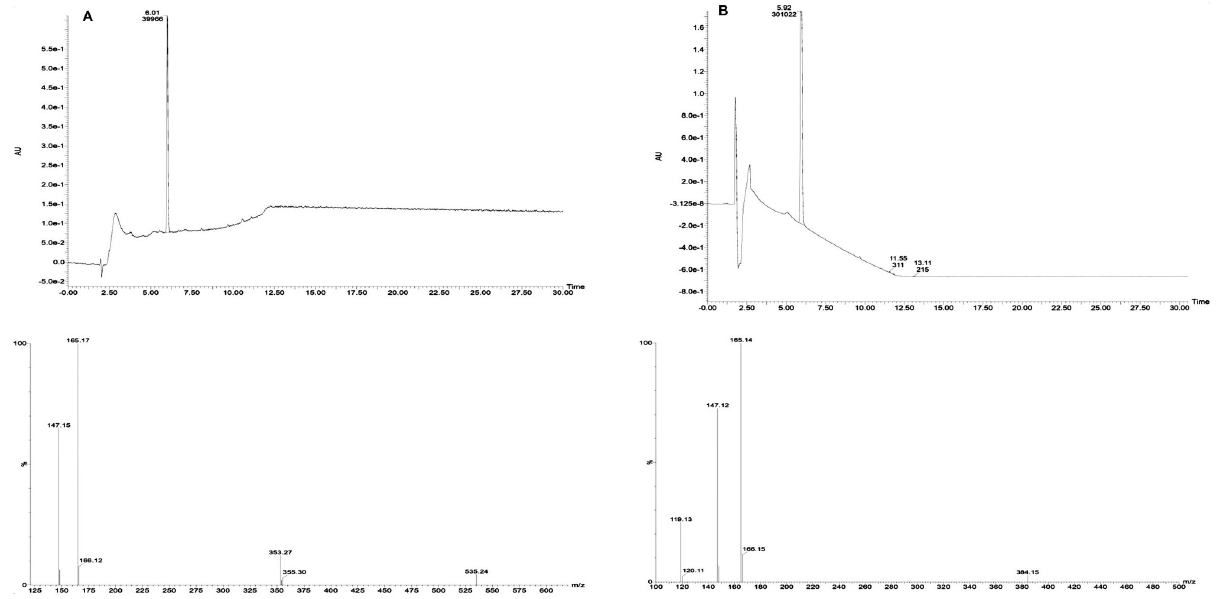
Fig 7. Confirmation and molar mass detection of3-phenyllactic acid by LC-MS (A) Standard 3-PLA (Sigma Aldrich), (b) LAB isolates.